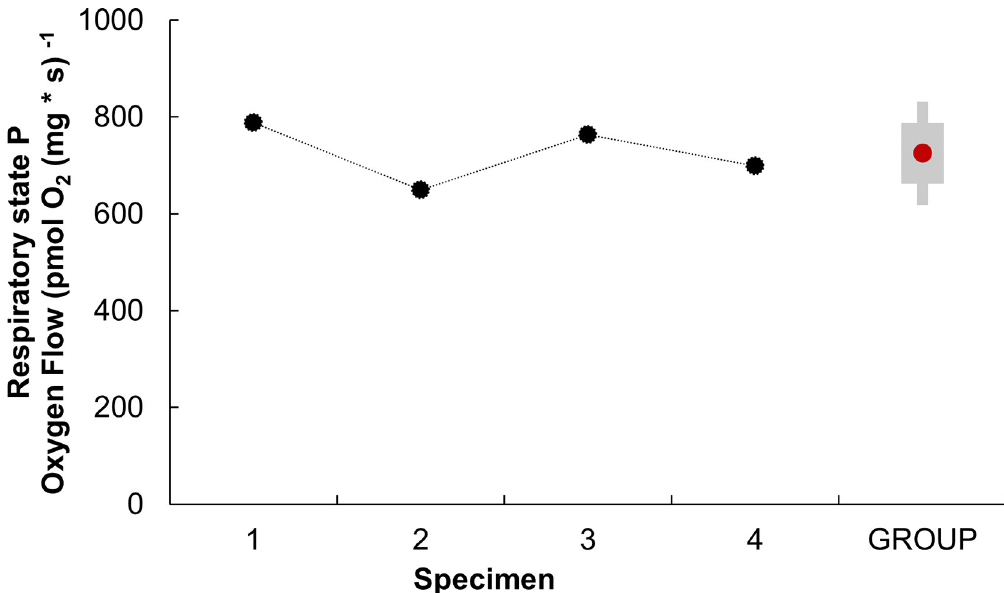
Fig 3. Phosphorylation state parameter ( P ) of isolated mitochondria from the systemic heart of Octopus maya . P of systemic heart mitochondria was obtained by subtracting the respiratory parameter S3 from the respiratory parameter S4o ( P = S3-S4o; S3 and S4 are ROX-corrected values: S3 = S3’-ROX y S4o = S4’o-ROX, respectively). The P was obtained individually (black dots) for each adult O . maya specimens (mean weight 1 348 ± 263.49 g) using a mitochondrial concentration of 377 ± 0.02 μ g ml -1. GROUP; represents the mean P value of the four specimens (red dot), +SD (gray box).